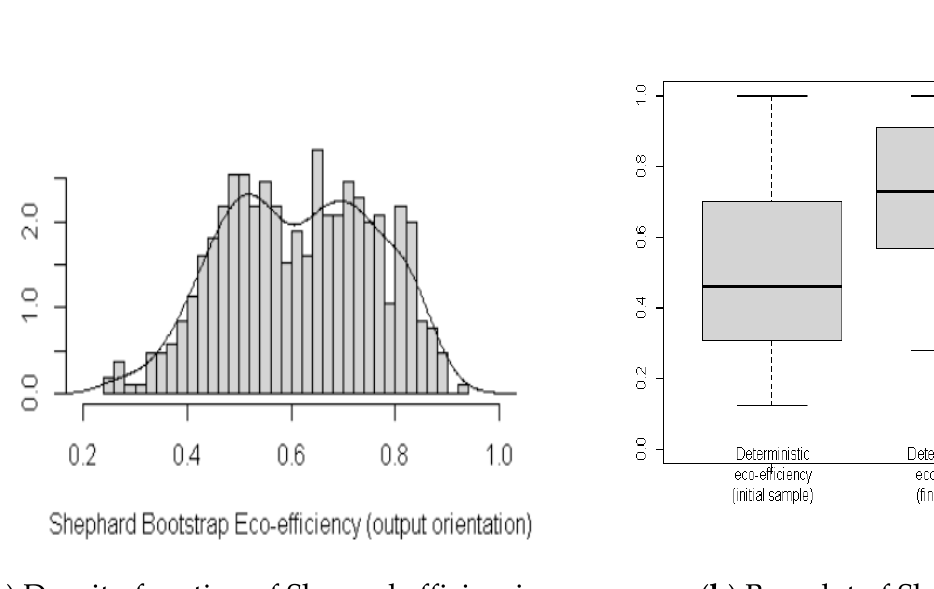
Figure 2. Shephard efficiencies oriented to outputs (Source: formulated by the authors.).